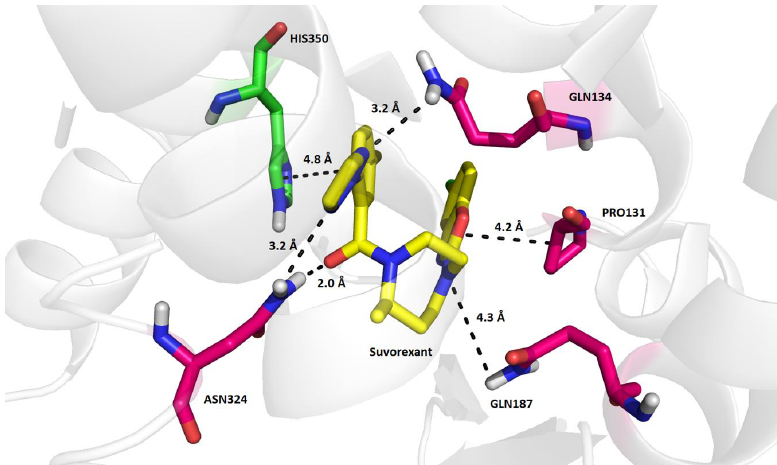
Figure 1. Binding mode of suvorexant in OX2R as determined by X-ray in the 4S0V model. The four residues colored in magenta (Pro131, Gln134, Gln187, Asn324) are mainly responsible for binding the antagonist in the active site of OX2R. On the contrary, His350 (in green) is a member of the proposed activation OX2R tetrad (e.g., Thr111, Asp115, His350, and Tyr354) responsible for eliciting the agonistic effect [23].